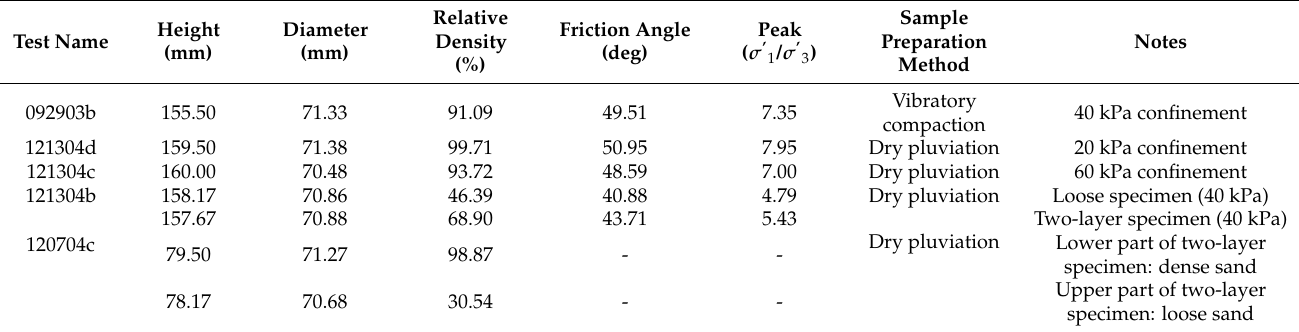
Table 1. Summary of sample